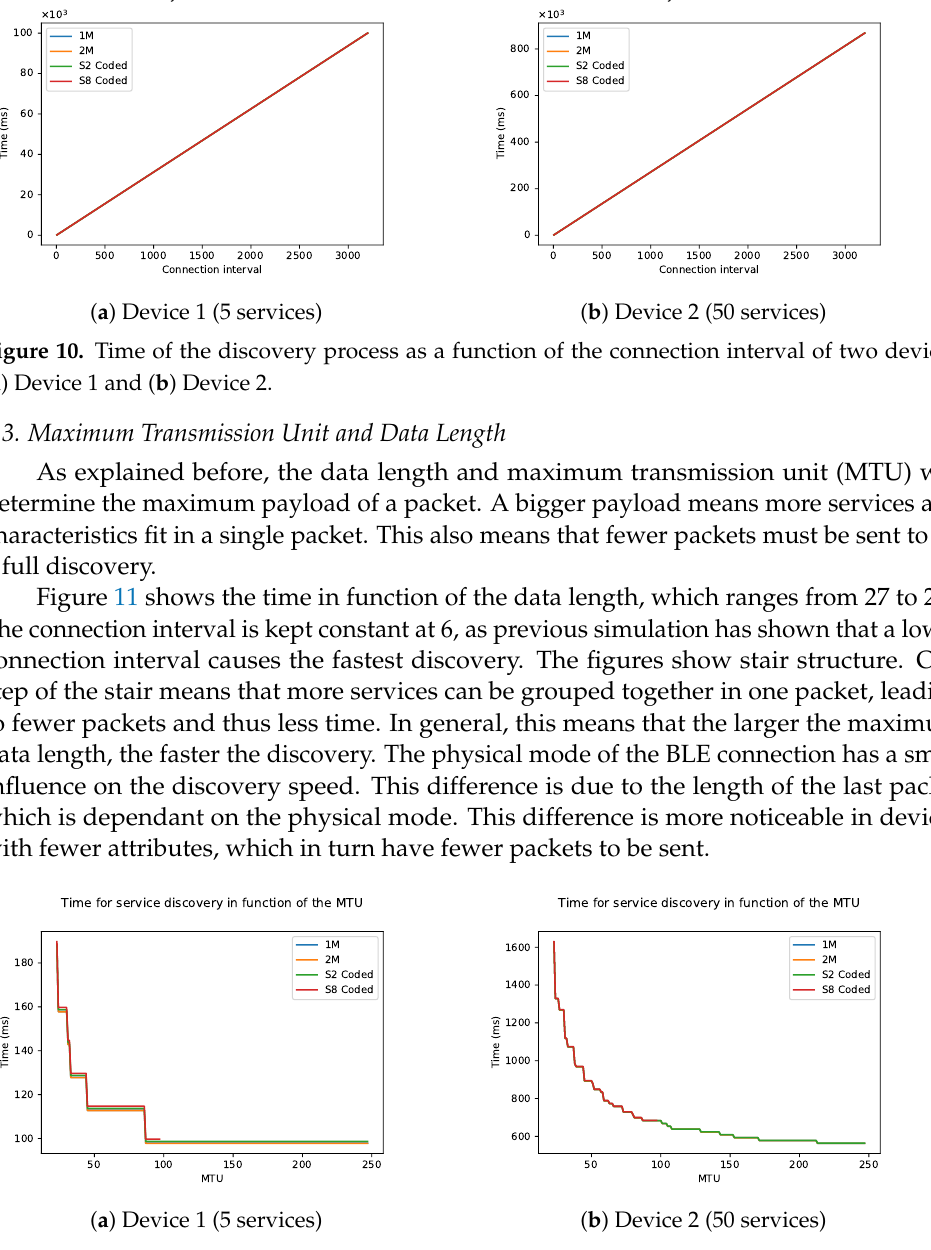
Figure 11. Time of the discovery process as a function of the MTU of two devices: ( a ) Device 1 and ( b ) Device